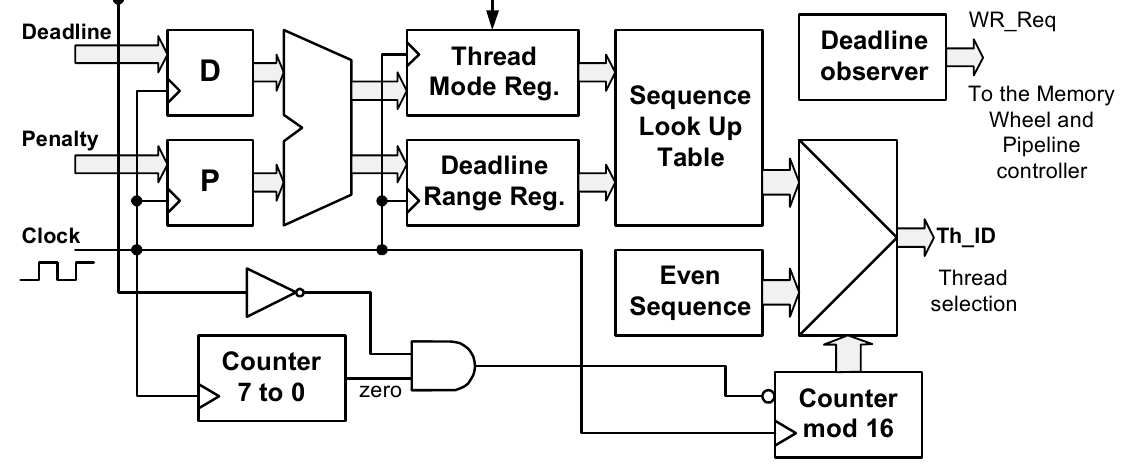
Figure 1. Dynamically scheduled PRET architecture with thread-interleaving and memory developed in IE SUT [4].